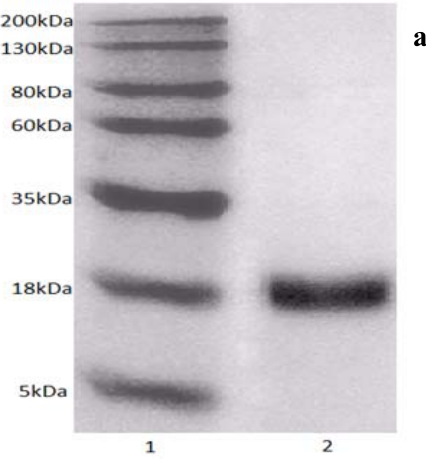
Figure 2. ( a ) SDS-PAGE of purified antioxidant protein from Ginkgo biloba seeds. Lane 1, Molecular weight marker; Lane 2, the purified antioxidant protein (GBSP); ( b ) chromatogram of purified protein (GBSP) by MALDI/MS analysis; ( c ) HPLC chromatogram of purified protein